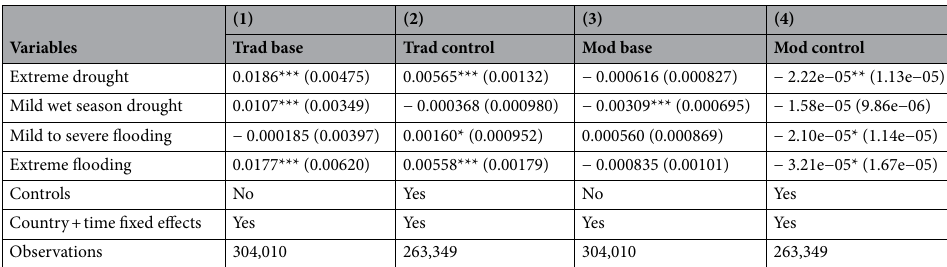
Table 2. Multinomial logits outcomes. Marginal effects. Clustered standard errors in parentheses. ***p < 0.01, **p < 0.05, *p < 0.1.